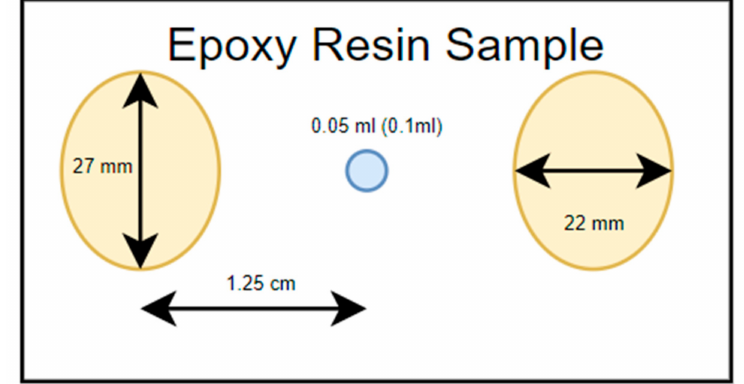
Figure 18. One-Droplet Arrangement